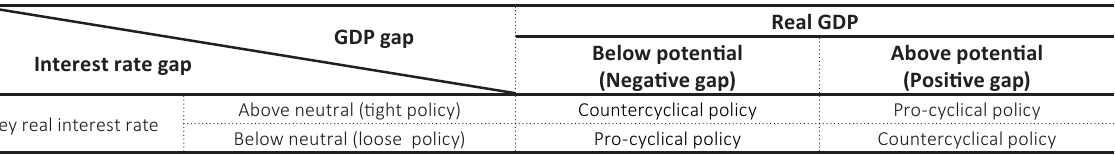
Table 1. Matrix of the type of monetary